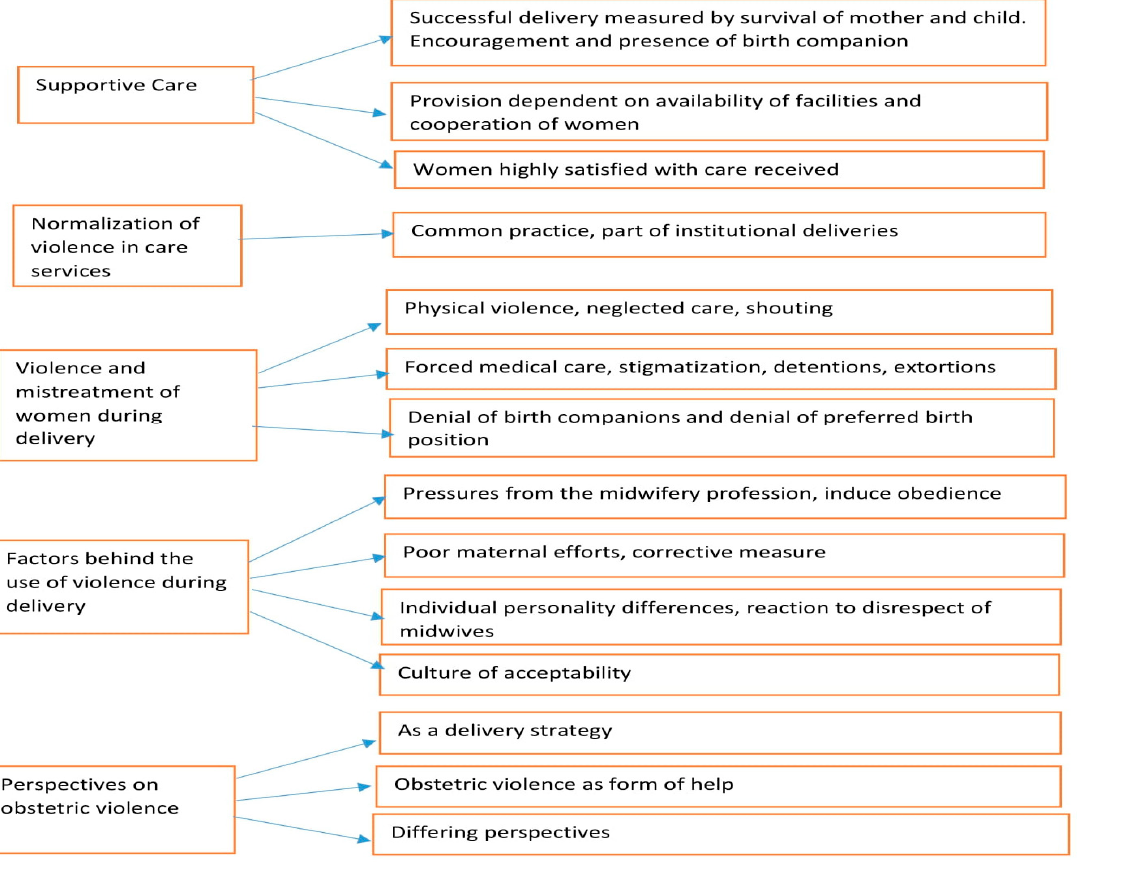
Figure 1. Major themes and sub-themes.